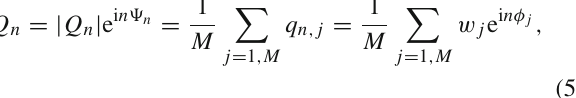
(cid:9)(cid:10) (cid:11) Q N n Q P ∗ n (right panel), for all | Q N || Q P | n n